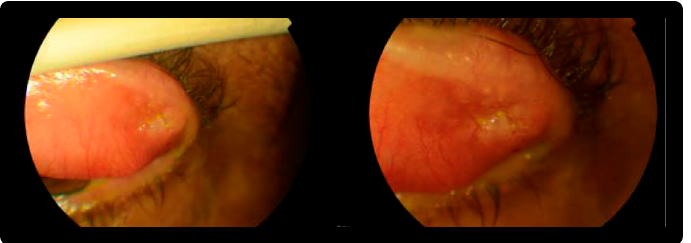
Figure 1. A 53-year-old man with a slightly elevated and palpable nodule measuring nearly 10 mm located in the lateral third of the upper left eyelid. A mild conjunctival hyperaemia was associated with the lesion, which had been progressively growing for nearly 1